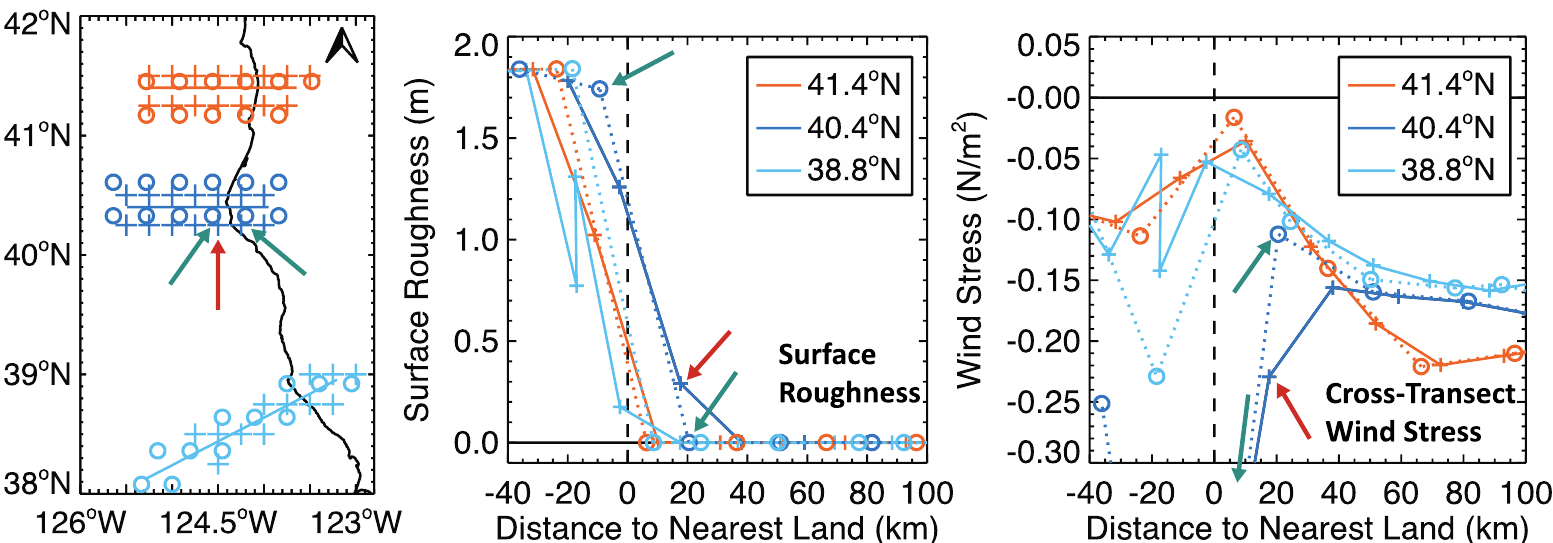
Figure 12. August 2005 averages of the surface roughness and cross-transect wind stress along the same three transects as in Figure 11. The circles and dotted lines show values on the ERA-5 native grid points (RGG). The pluses and solid lines show values on the interpolated regular lat-lon grid. ( Left ) On the line of points south of the transect across Cape Mendocino (40.4°N), the red arrow points to the interpolated grid point over water next to the coast. The green arrows point to the RGG grid points on either side of the coastline and on either side of the interpolation grid point. ( Middle ) Surface roughness at a subset of grid points on both the RGG and interpolated grids. For clarity, data is presented only for the northern of the two orange lines, for the southern of the two dark blue lines and ignoring the three most northern of the light blue points. Roughness increases over land and at the interpolated grid point next to Cape Mendocino in comparison to farther offshore (red arrow). ( Right ) Cross-track wind stress on the same grid points as used for surface roughness. All wind stress values are negative (equatorward). Moving toward the coast from offshore, wind stress magnitudes decrease on the RGG grid as land is approached (circles). Off Cape Mendocino, wind stress magnitudes increase on the interpolated grid point over water next to the coast (red arrow), while an RGG grid point with reduced magnitude lies slightly farther offshore of it (upper green arrow) and the first RGG grid point over land has a much greater magnitude (off the figure to the bottom left), inshore of the coastline.